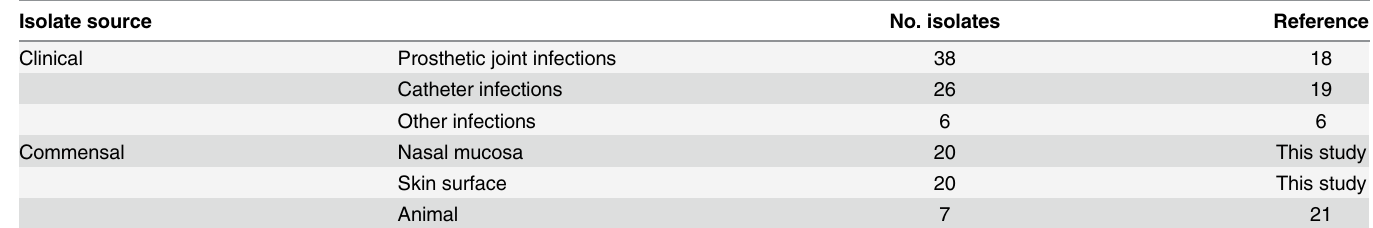
Table 1. List of the S . epidermidis isolates used in the